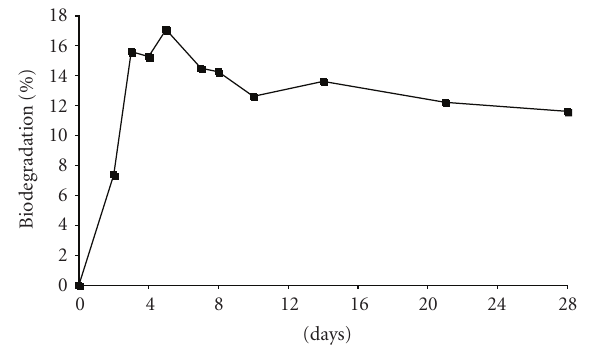
Figure 6: Evolution of the biodegradability following the Zahn Wellens process carried out on the CHPYR phototreated e ffl uent.